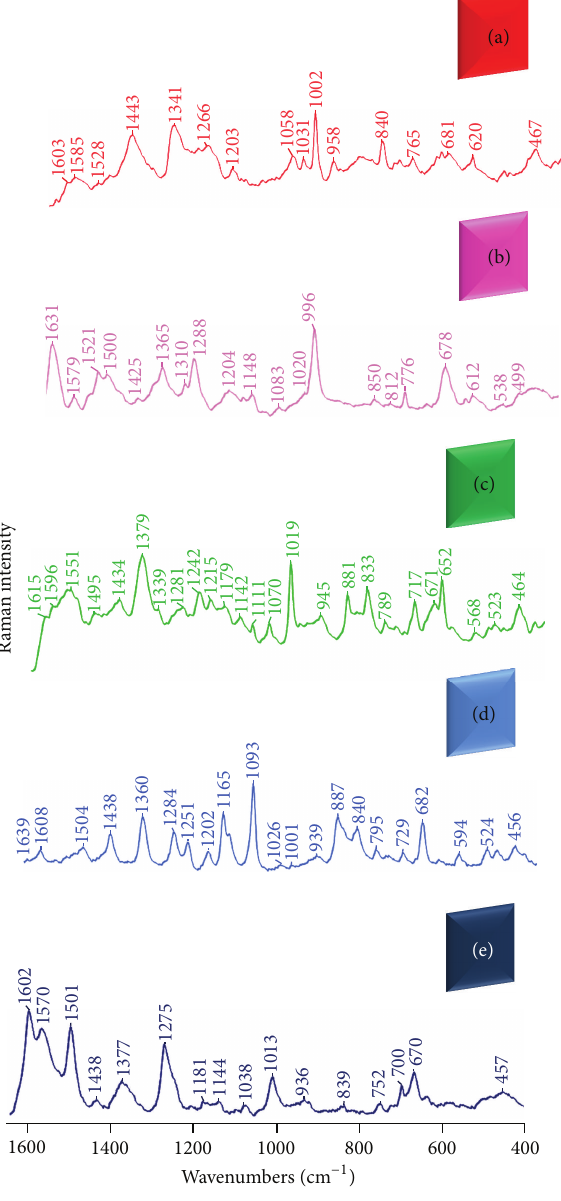
Figure 1: The SERS spectra of (a) BK and its analogues: (b) [D-Arg 0 ,Hyp 3 ,Thi 5,8 ,L-Pip 7 ] BK, (c) Aaa[D-Arg 0 ,Hyp 3 ,Thi 5,8 ,L-Pip 7 ]BK, (d) [D- Arg 0 ,Hyp 3 ,Thi 5 ,D-Phe 7 ,L-Pip 8 ]BK, and (e) Aaa[D-Arg 0 ,Hyp 3 ,Thi 5 ,D-Phe 7 ,L-Pip 8 ]BK adsorbed onto a colloidal Au particles surface in an aqueous